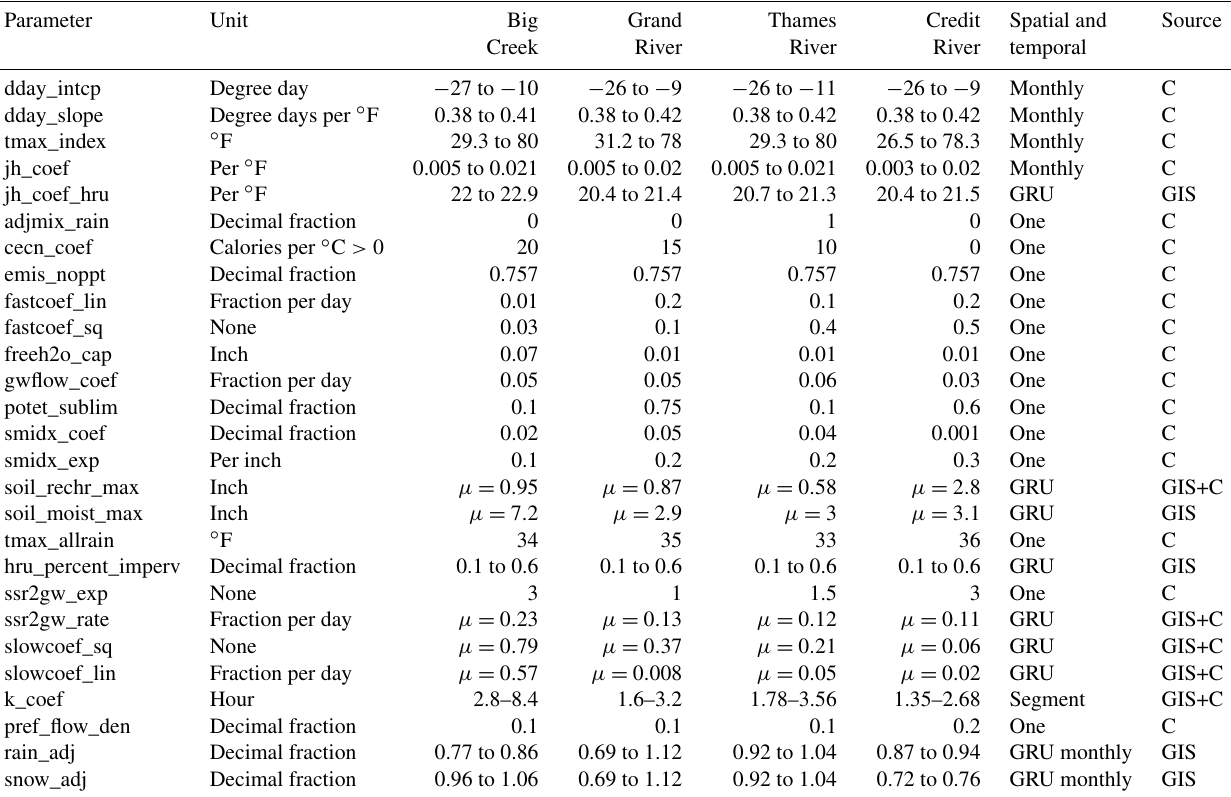
Table 2. Parameter values after calibration. C: calibrated; GIS (geographic information system): estimated by Arcpy-GSFLOW; µ : GRU average. All parameters definitions can be found in Markstrom et al.